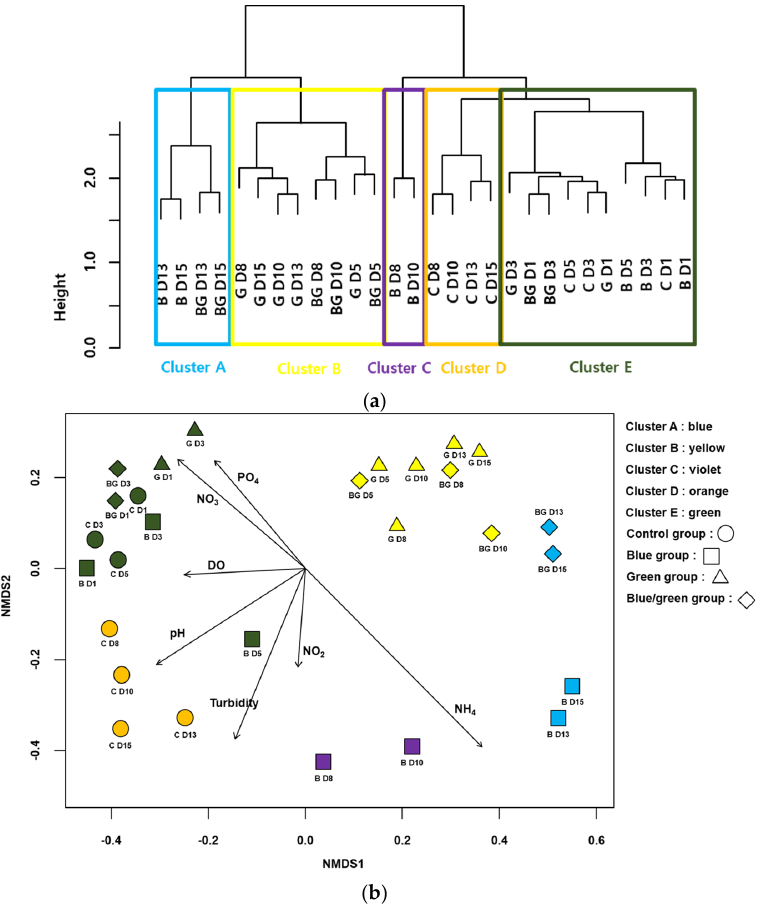
Figure 5. Cluster analysis based on cyanobacteria-associated bacteria assemblages ( a ) Non-metric multidimensional scaling (NMDS) ordination of samplings with cyanobacteria-associated bacteria assemblages ( b ). Arrows indicate the water quality variables significantly related to the assemblage compositions ( p < 0.05). The longer the arrow length, the higher the correlation coefficients with the axis of NMDS. The first letter in figures indicates the experimental condition (i.e., C: control, B: blue film, G: green film, BC: blue and green light) and the number indicates the experimental date (D1: 24 h, D3: 72 h, D5: 14 h, D8: 196 h, D10: 240 h, D13: 312 h and D15: 360 h). Fifty-two taxa were selected as indicator species (or taxa) for the five groups from the